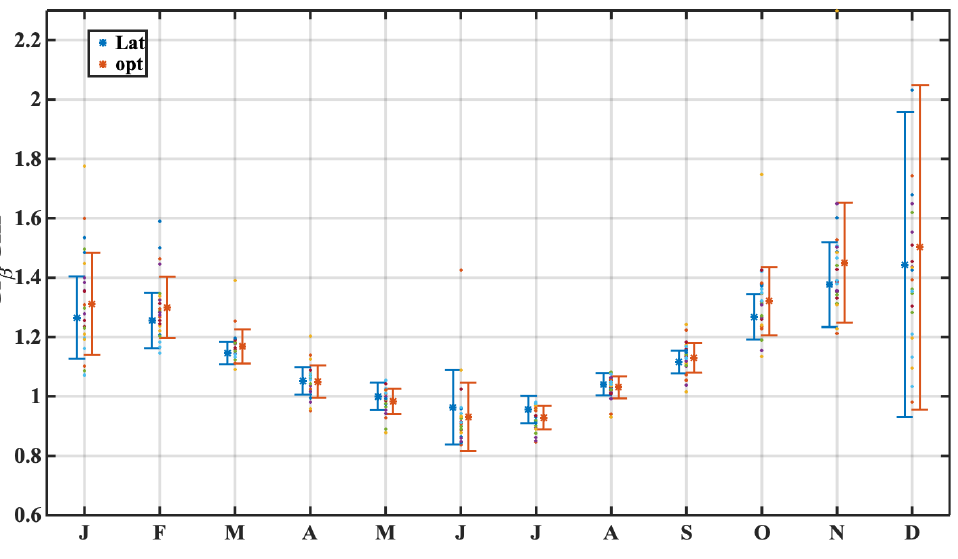
Figure 4. Ratio of GI β on inclined surface to horizontal one, for each month. Mean value for each month for β = Latitude and β = optimum angle, along with error bars representing the 1 σ standard deviation of ratios for each month. Small points are all 25 cities ratios for each month.